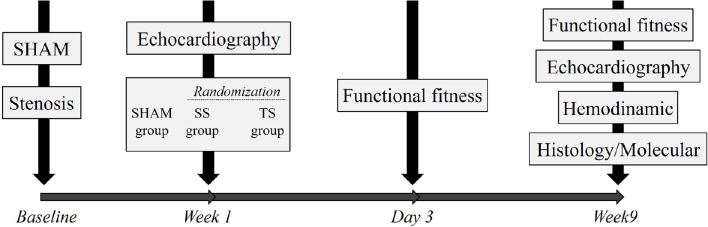
Experimental design.